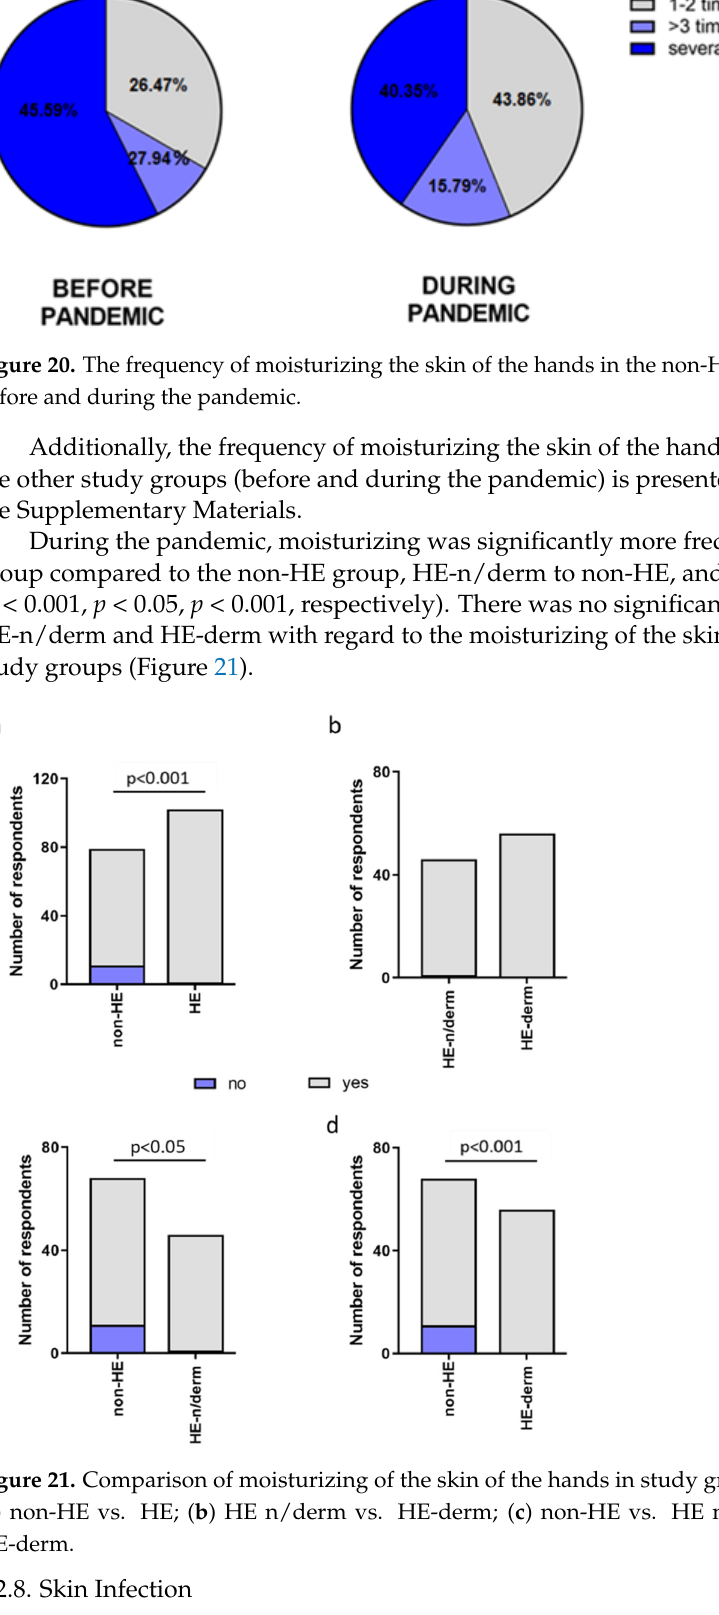
Figure 19. The frequency of moisturizing the skin of the hands in the HE group of respondents before and during the pandemic.